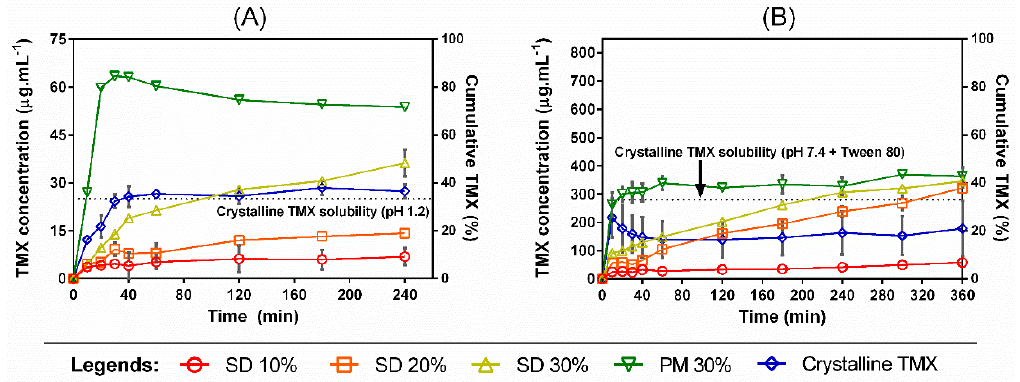
Figure 6. Dissolution profiles under non-sink conditions of crystalline TMX, SDs, and PM 30% in ( A ) HCl pH 1.2 buffer and ( B ) phosphate buffer pH 7.4 + Tween 80 (0.4% w/v ). The dotted line represents TMX equilibrium solubility in each dissolution medium. Error bars represent the standard